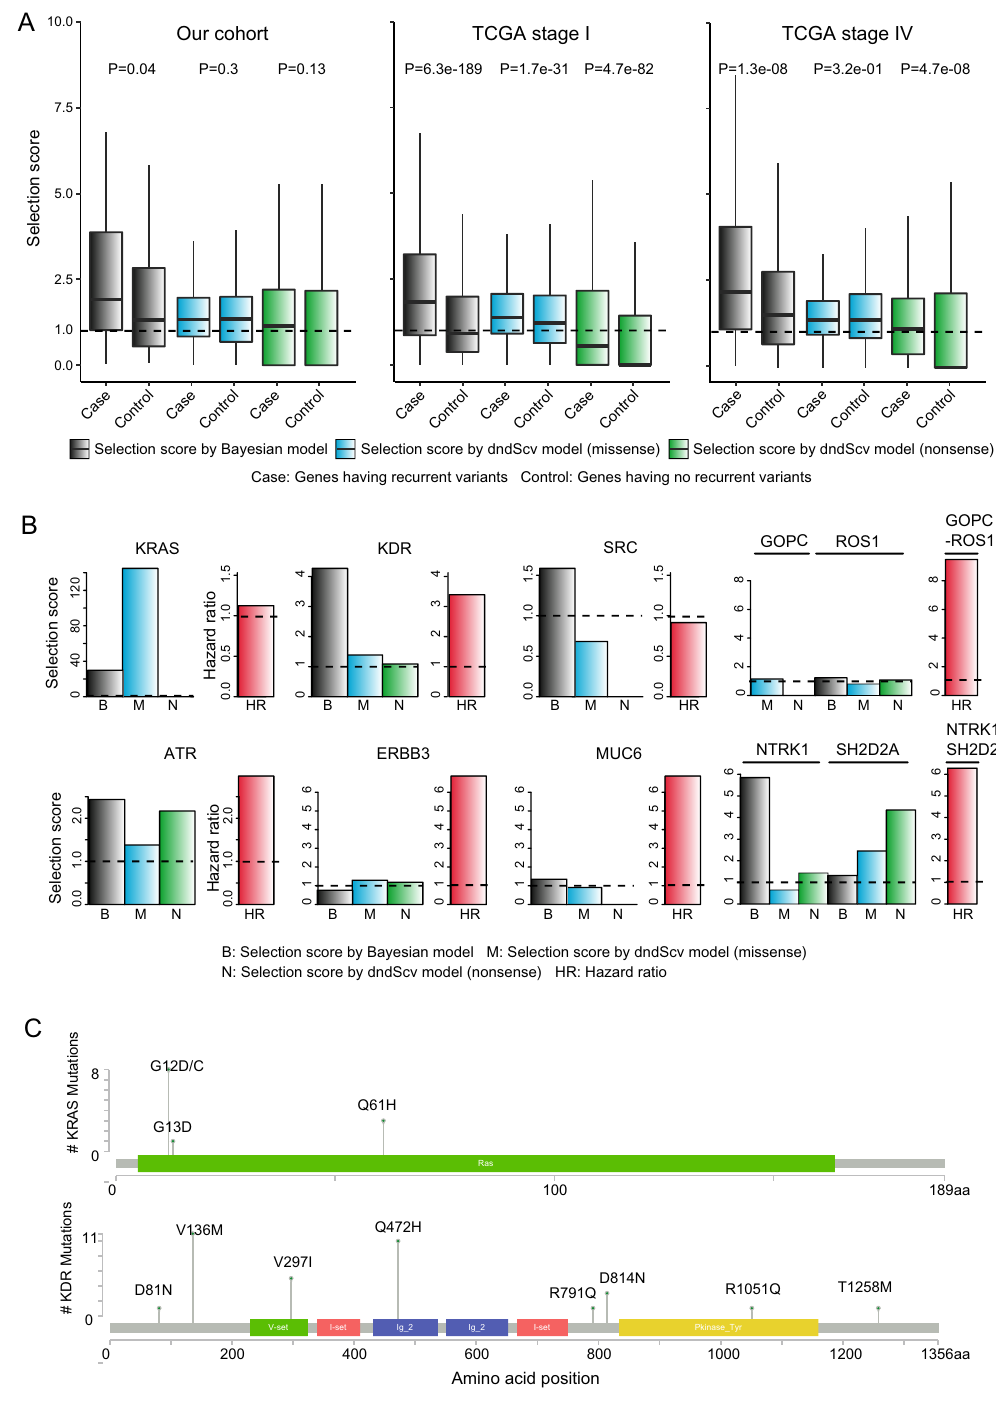
Figure 4. Selective signatures of recurrent gene mutations and fusions. ( A ) Selection values were calculated based on the Bayesian inference and covariate model ( dNdScv ) for the genes having variants of which frequency was over two. The genes with recurrent variants were compared to the genes with no recurrent variants within our cohort (left), stage I TCGA samples (middle), and stage IV TCGA samples (right). The gene numbers that were analyzed by Bayesian inference were 80, 4567, and 256 for our cohort, TCGA stage I samples, and TCGA stage IV samples, respectively. The gene numbers that were analyzed for the selection values by the covariate model were 89, 6863, and 1646 for our cohort, TCGA stage I samples, and TCGA stage IV samples, respectively. ( B ) Selection values for the genes that had a significant association with recurrence-free survival were described. Shown are the selection values obtained for lung adenocarcinoma (LUAD) samples from TCGA. dNdScvM is the normalized ratio of nonsynonymous to synonymous mutations (dN/dS) for missense mutations. ( C ) Genomic structure with amino acid position was described by using MutationMapper tool 35 for KRAS and KDR. The frequency of each amino acid mutation is shown according to its